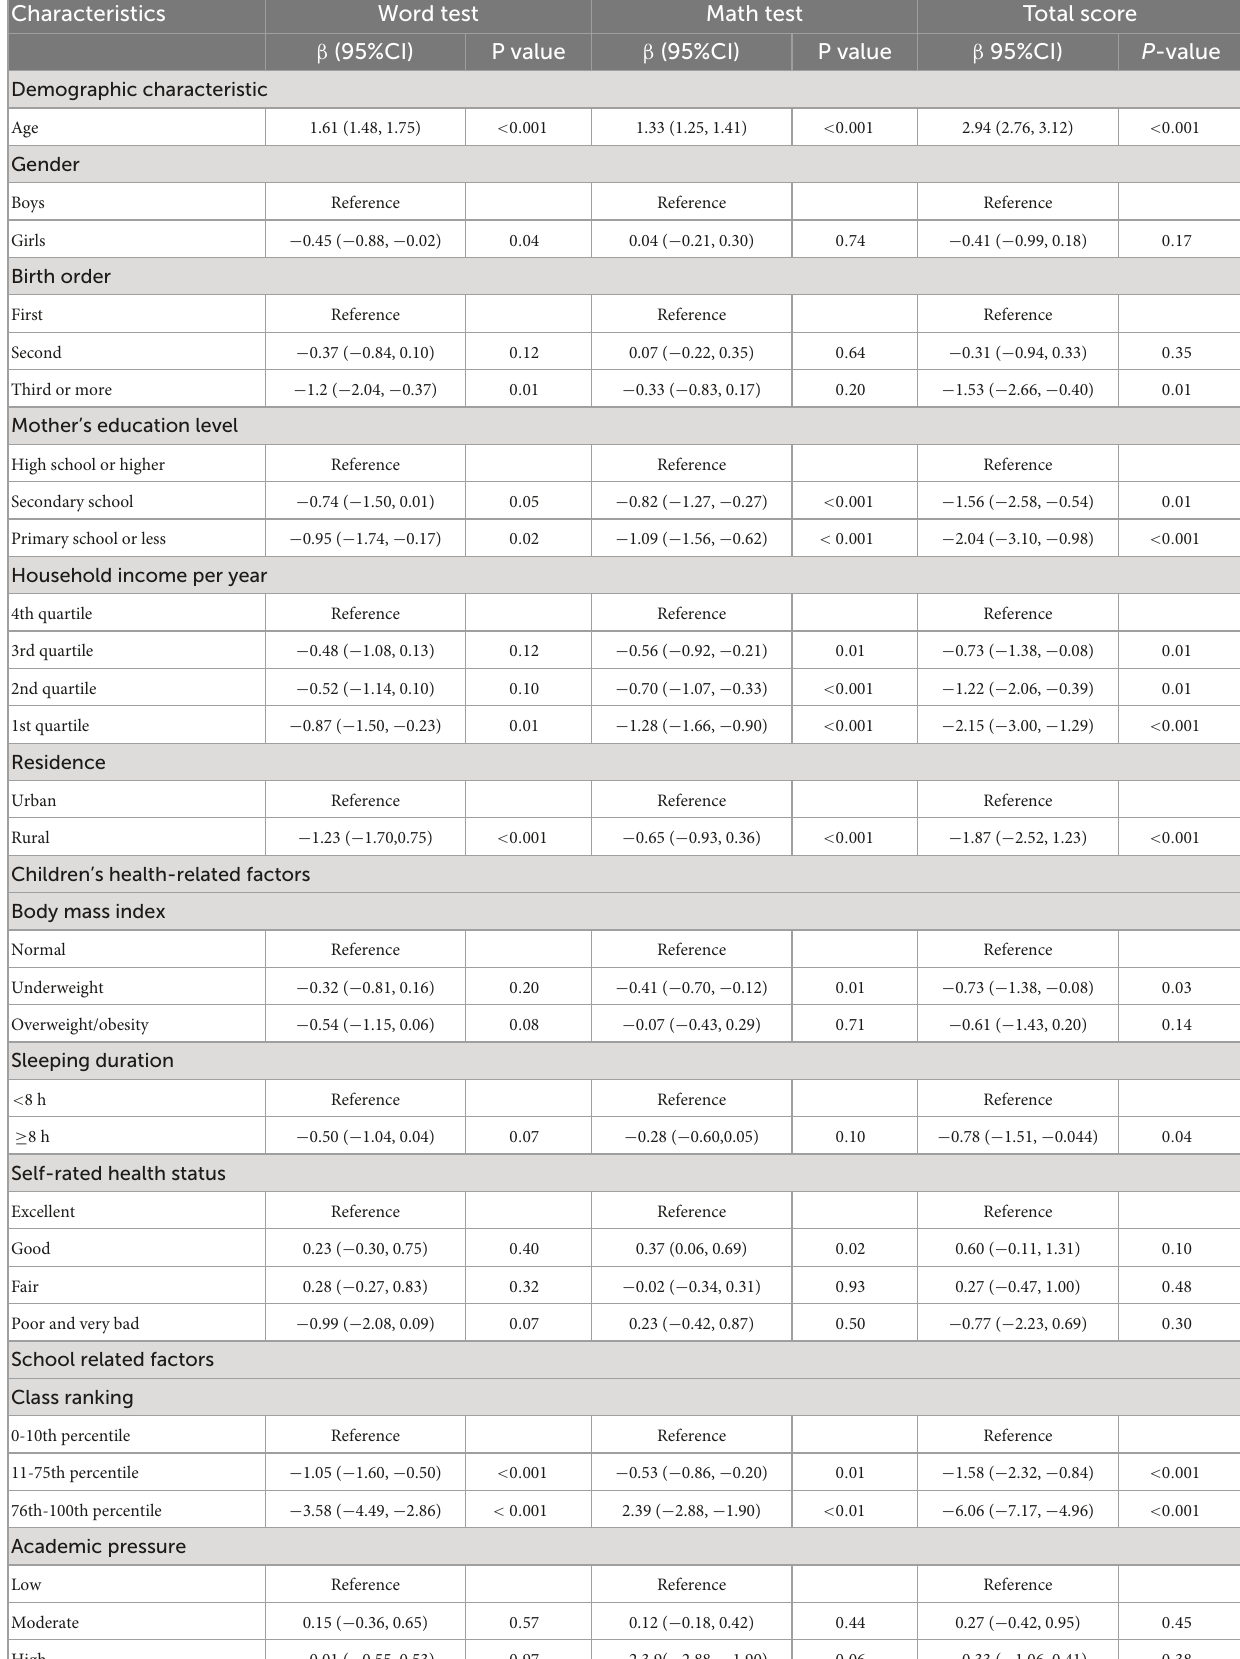
TABLE 5 Multivariable linear regression analysis of the associated factors with the cognitive level in the imputed dataset ( n = 2106). Characteristics Word test Math